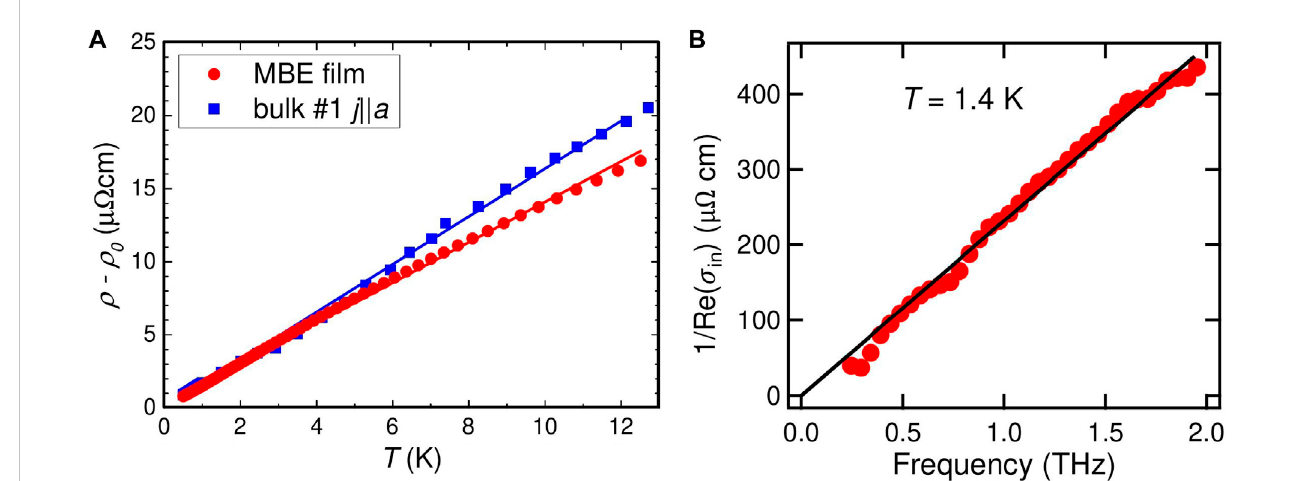
FIGURE 5 DcandTHzresistivityofYbRh 2 Si 2 . (A) Thedcresistivityislinearintemperature.TheslopesofthecurveforanMBE fi lmandabulksinglecrystalaresimilar. (B) At 1.4 K, the inverse of the real part of the low-temperature intrinsic optical conductivity, 1/Re( σ in ), of the MBE fi lm is approximately linear in frequency. Figures from (Prochaska et al., 2020).